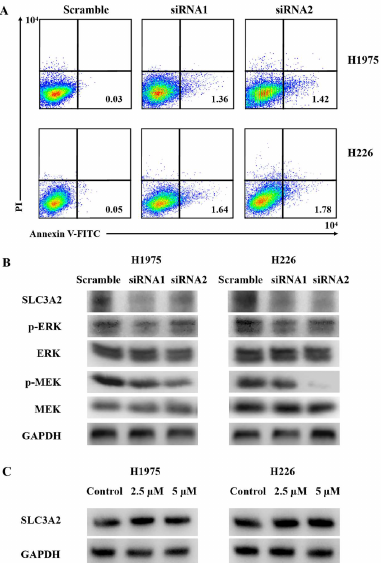
Figure 8. The roles and mechanisms of SLC3A2 in LUAD and LUSC cells. ( A ) The proportion of apoptotic cells (early apoptosis) was determined by double staining with Annexin-V/FITC and PI. ( B ) Western blot analysis of the ERK/MEK signaling pathway. GAPDH was used as an internal loading control. ( C ) Methylation status of SLC3A2 in LUAD and LUSC cells was checked using 5-AzaC. Uncropped WB images are shown in Archive S1.